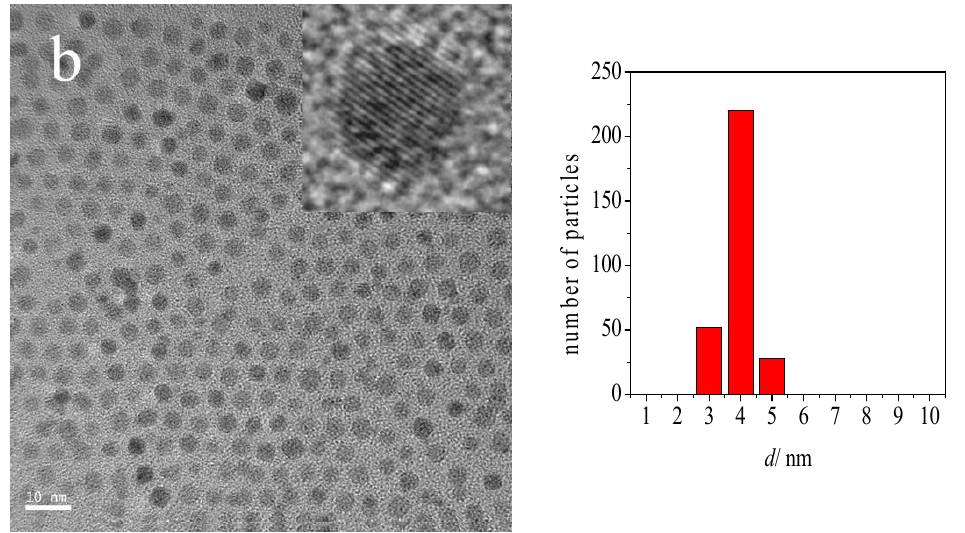
Figure 1. Transmission Electron Microscopy (TEM) images (left) and particle size distributions (right) of ( a ) Au ‐ dodecylamine (DDA) colloid; and ( b ) Au ‐ DDA colloid (w). The inset in the TEM image ( b ) shows the crystallinity of an Au nanoparticle.